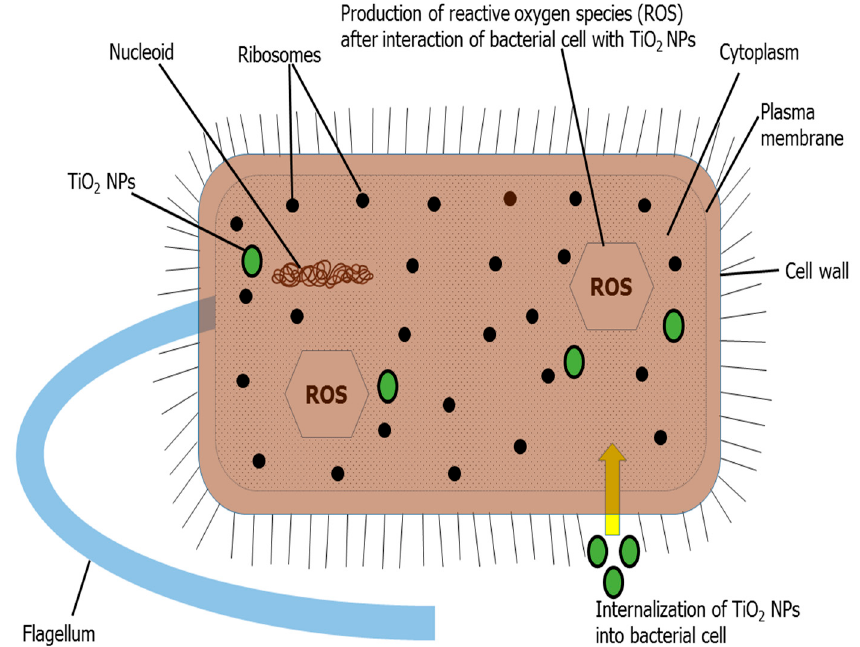
Figure 7. Diagrammatic illustration of mechanism of bactericidal activity of TiO 2 nanoparticles.